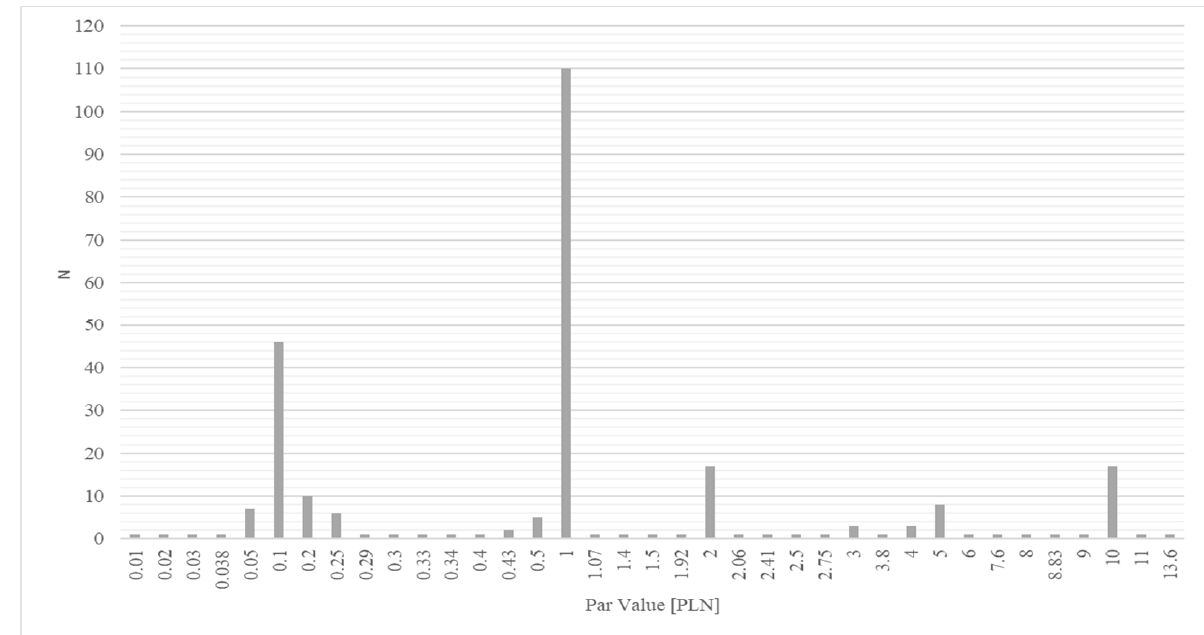
Figure 1. Par value distribution.